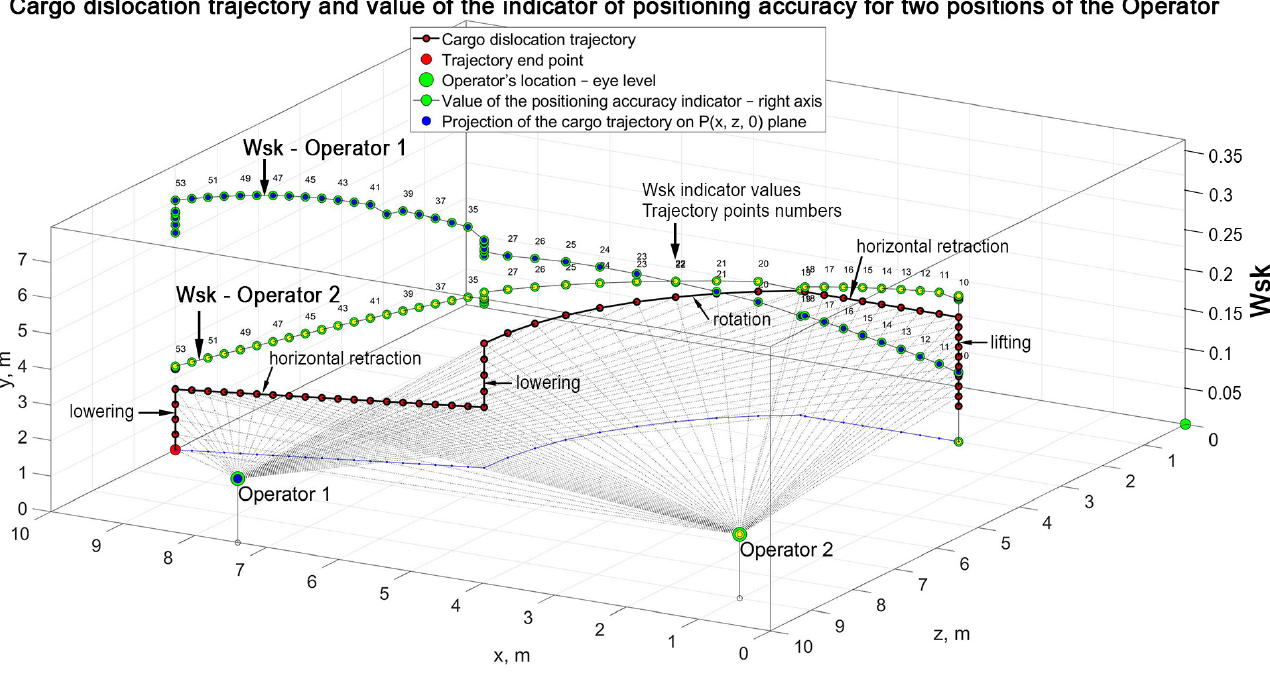
Figure 21. Cargo dislocation trajectory and value of the indicator of the positioning accuracy for two positions of the operator. Shaping of the values of the indicator of the accuracy of positioning W sk . Table 5. Sequence of the movement of the crane working